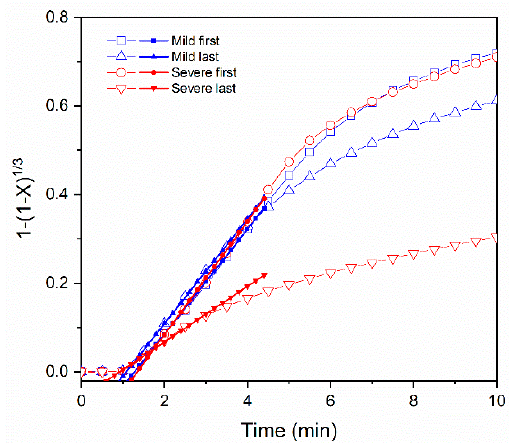
Figure 9. CaO carbonatation kinetic curves of the CCZ40 sorbent for the first and last cycles under mild conditions (blue) and under severe conditions (red) and the corresponding slope extraction according to the grain model.